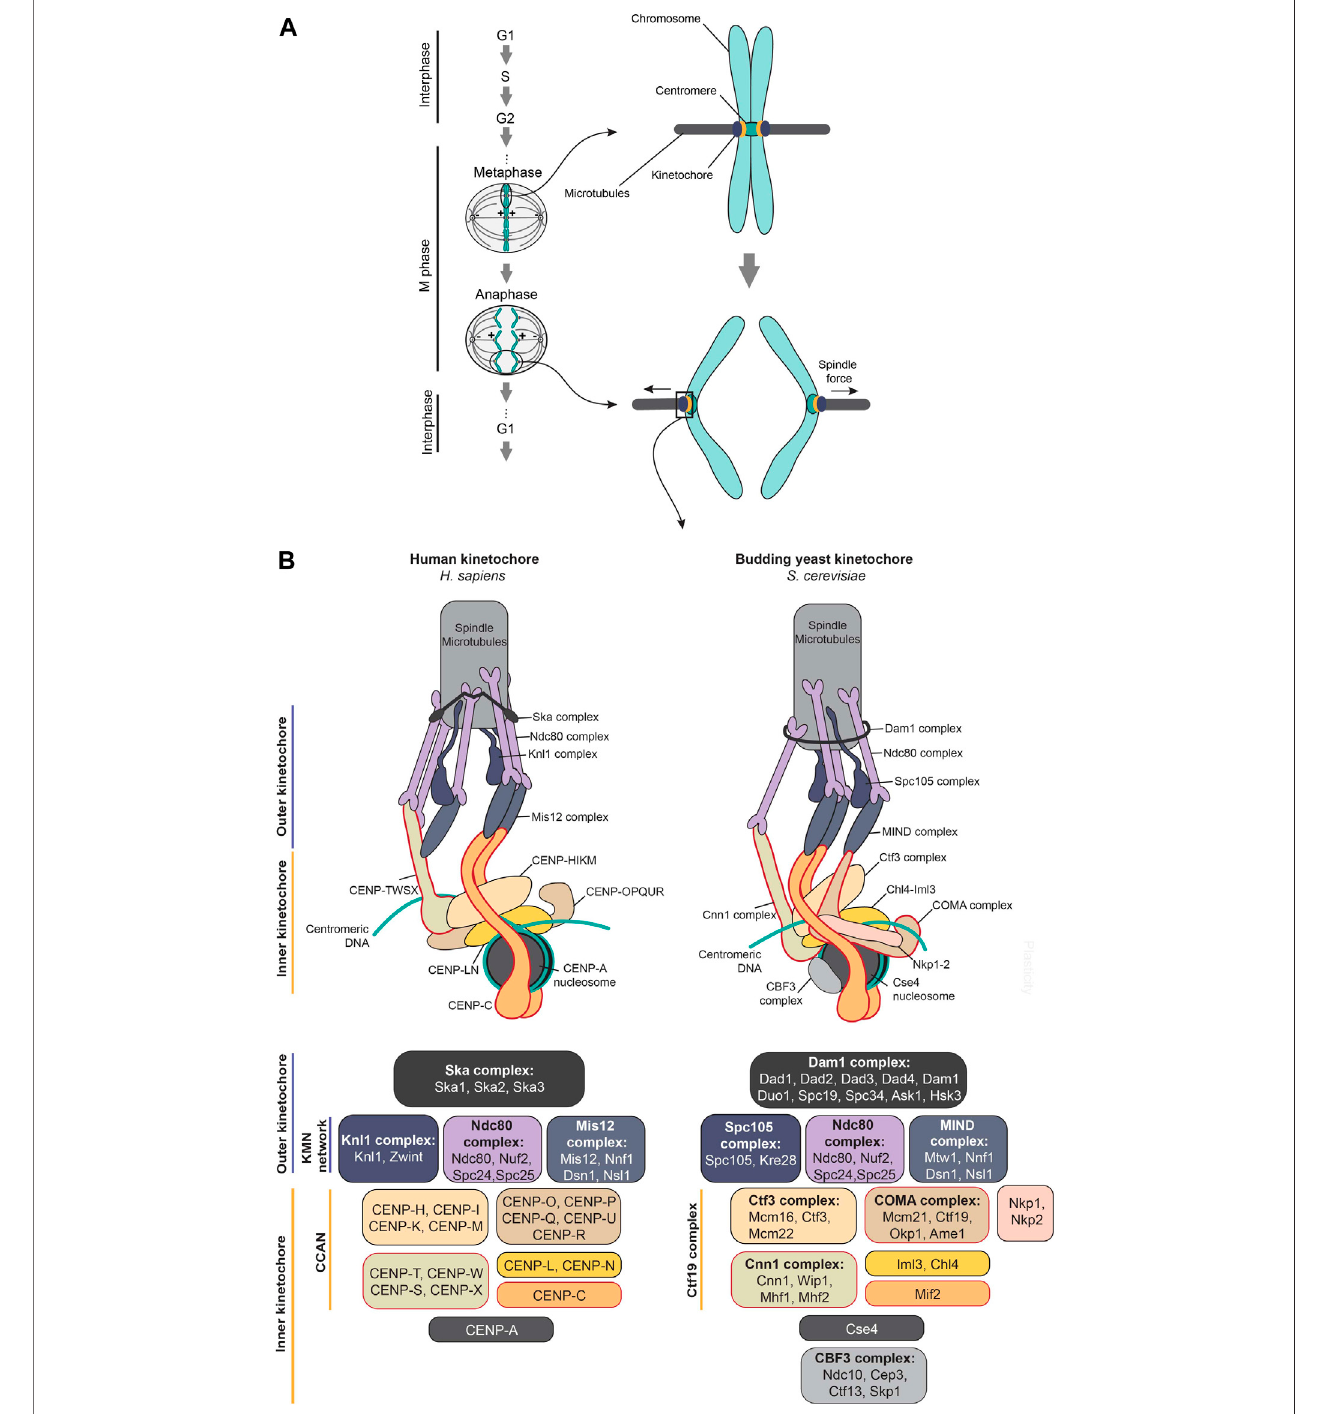
FIGURE 1 | Schematic of kinetochore composition and architecture in human and budding yeast systems. (A) A functional kinetochore is assembled in M-phase oncentromericchromatinandfacilitatesinteractionwithspindlemicrotubulestoensureaccuratechromosomesegregation. (B) Thekinetochoreensemblecomprisesof the inner and outer kinetochore networks. The constitutive centromere associated network (CCAN) at the inner kinetochore ensures the adequate recruitment of the outer kinetochore KMN network through speci fi c linker proteins such as CENP-T and CENP-C in vertebrates and also CENP-Q Okp1 -U Ame1 in budding yeast (highlightedin abold maroon border).Although kinetochores acrosseukaryotesfunctiontoensureaccurate chromosomesegregation, plasticity acrossits composition and architecture is observed which is more pronounced amongst inner kinetochore components. Homologous complexes between human and budding yeast kinetochore components have the same color codes. Kinetochore homologs have been mentioned in the corresponding positions.